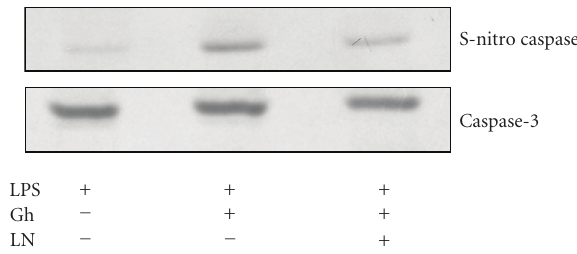
Figure 8: E ff ect of cNOS inhibitor, L-NAME (LN), on ghrelin- (Gh-) induced caspase-3 S-nitrosylation in gastric mucosal cells exposed to H. pylori LPS. The cells were treated with Gh (0.5 μ g/mL) or LN (300 μ M)+Gh and incubated for 16h in the presence of 100ng/mL LPS. A portion of the cell lysates was processed by biotin-switch procedure for protein S-nitrosylation and, along with the reminder of the lysates, subjected to SDS-PAGE, transferred to nitrocellulose, and probed with anti-caspase-3 antibody. The immunoblots shown are representative of three